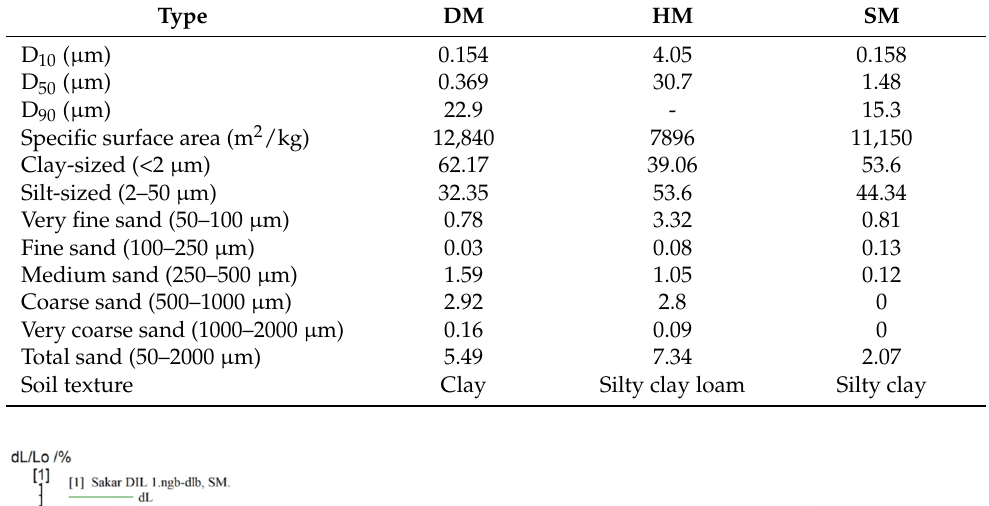
Figure 3. Particle size distributions of DM, HM, and SM clays. Table 3. Physical properties of DM, HM, and SM clays.